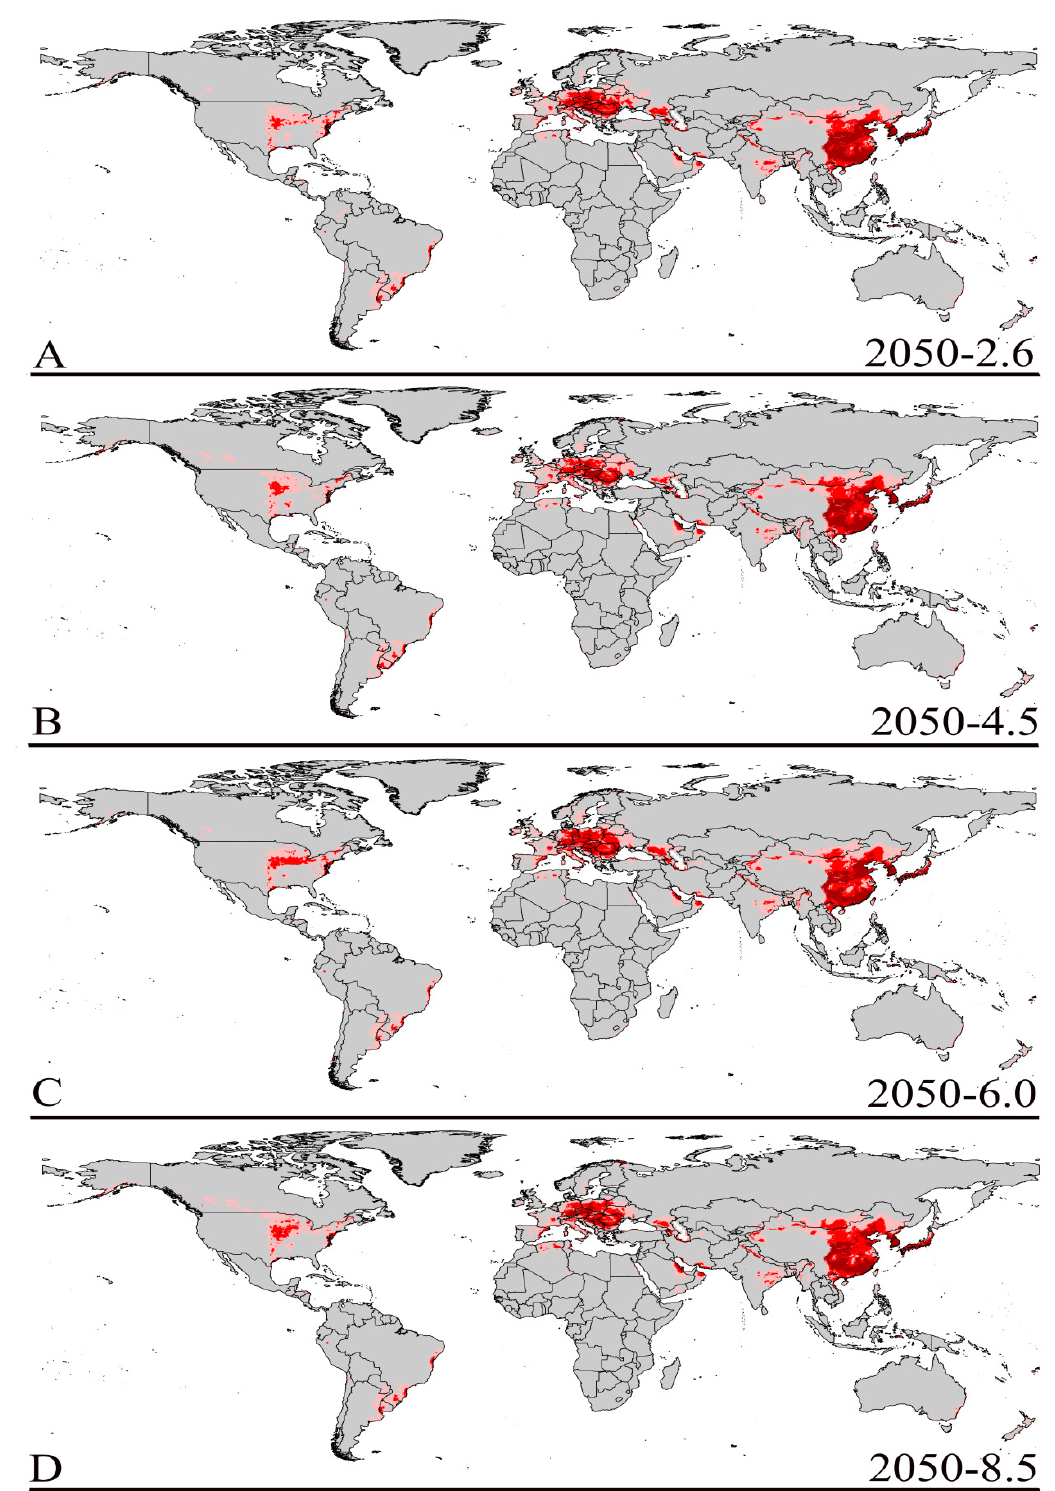
Figure 4. Future distribution models of Pseudaulacaspis pentagona on globe under different climate scenarios predicated by MaxEnt. Gray, unsuitable habitat area; Pale red, low habitat suitability area; Red, moderate habitat suitability area; Dark red, highly habitat suitability area. RCP: Representative Concentration Pathway. ( A ) RCP 2050-2.6; ( B ) RCP 2050-4.5; ( C ) RCP 2050-6.0; ( D ) RCP 2050-8.5.